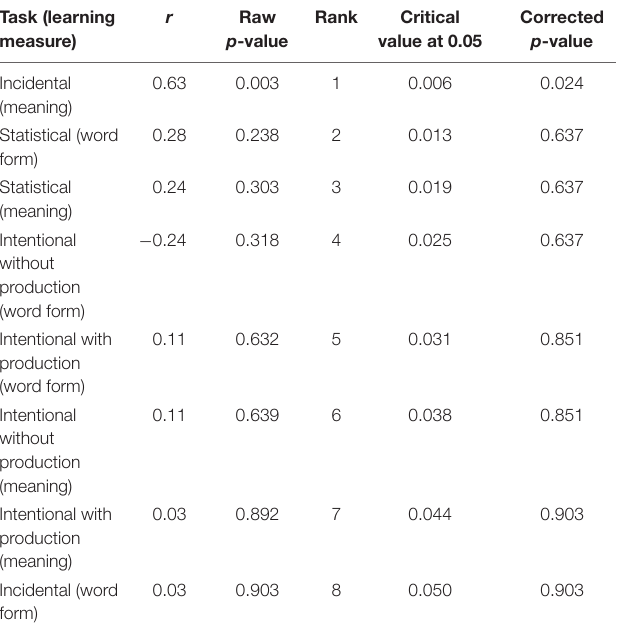
TABLE 5 | Correlations between Phonological Processing and learning performance with critical values of the Benjamini–Hochberg correction at an FDR of 0.05 and corrected p -values.